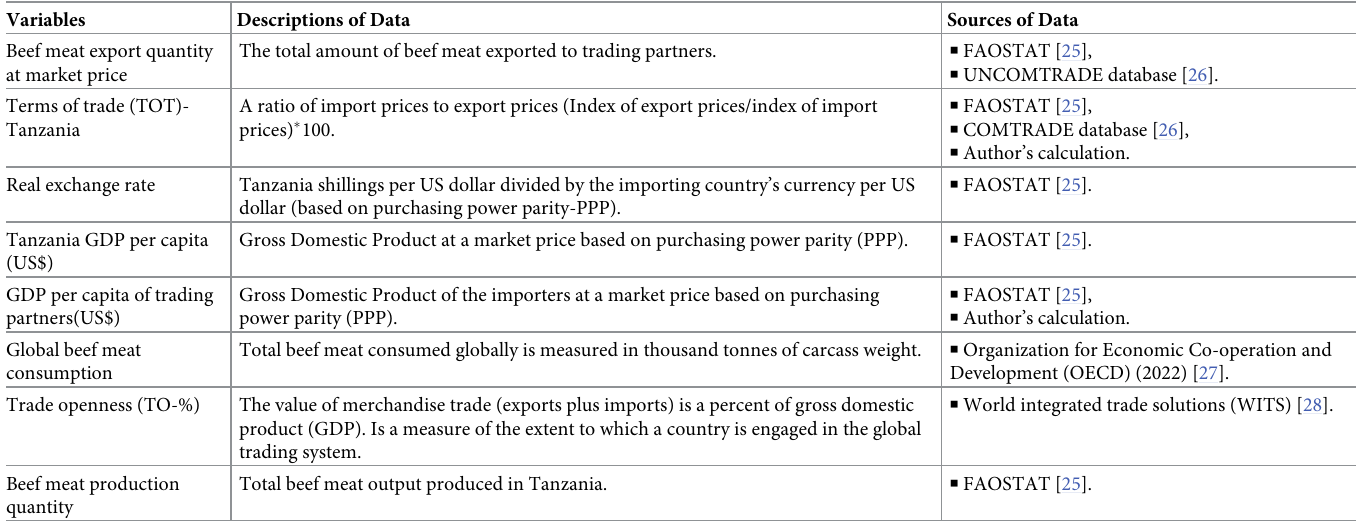
Table 1. Sources of data and descriptions of